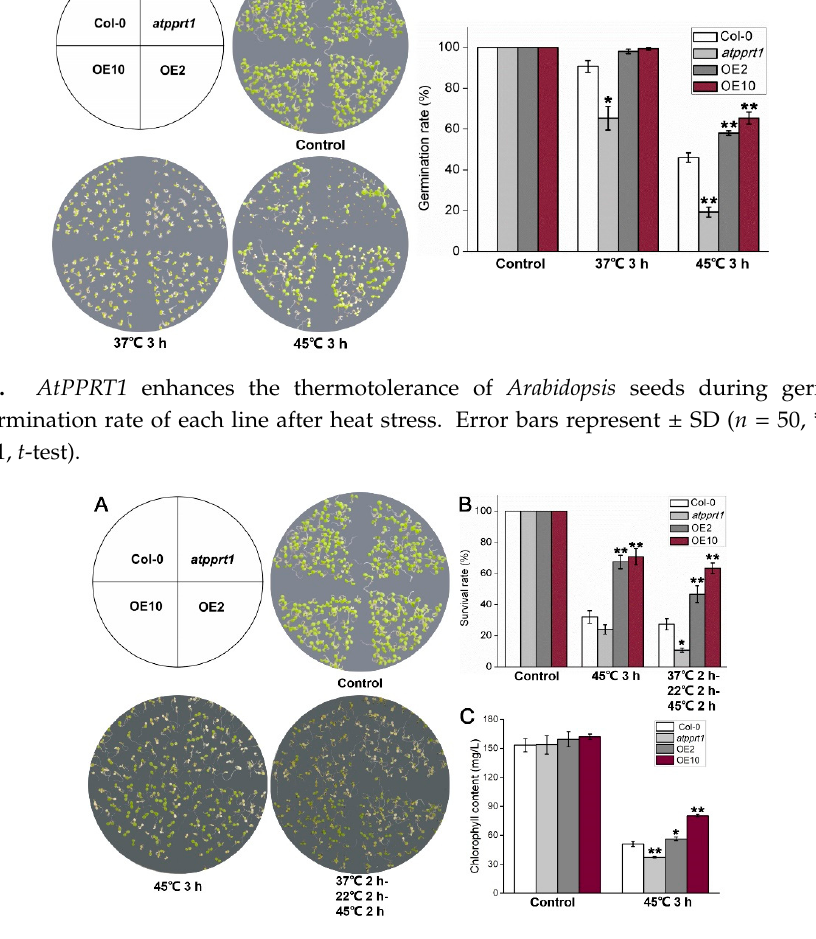
Figure 3. AtPPRT1 enhances thermotolerance in Arabidopsis seedlings. ( A , B ) Survival rate of each line after heat stress. Error bars represent ± SD ( n = 50, * p < 0.05, ** p < 0.01, t -test); ( C ) the chlorophyll content of each line after heat stress. Error bars represent ± SD ( n = 3, * p < 0.05, ** p < 0.01, t -test).